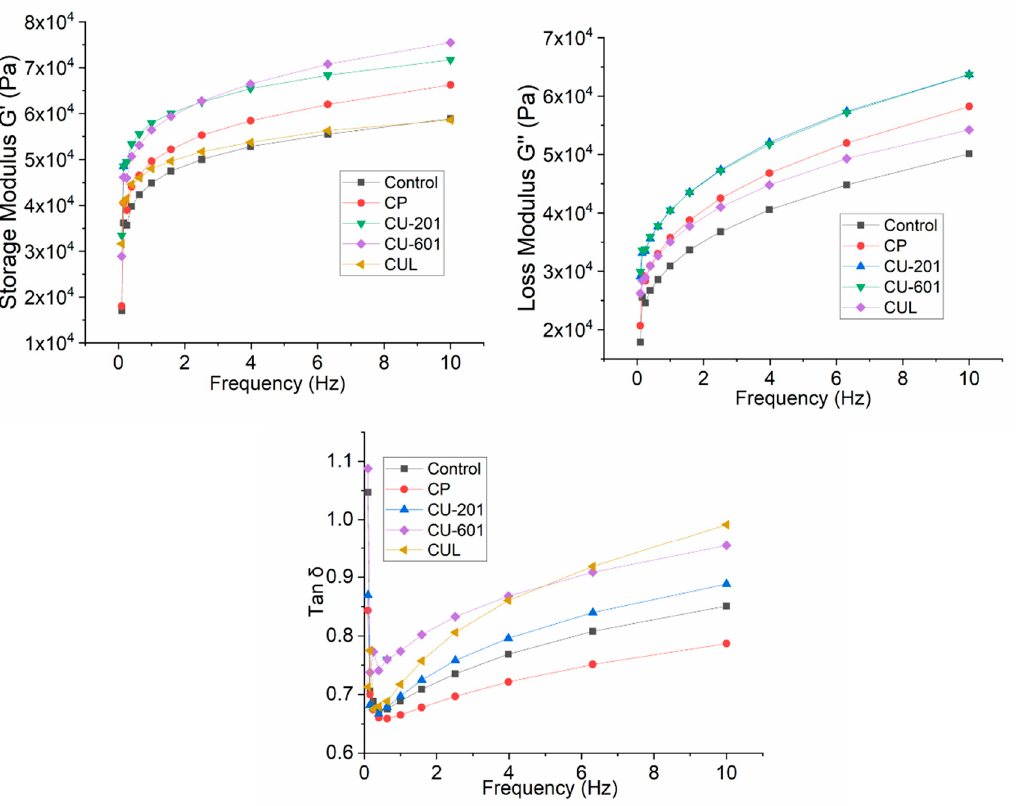
Figure 1. Rheological properties of cookies dough prepared with pectin having different molecular structure and molecular weight. CUL, CP, CU-601, and CU-201 indicate the names of pectin which were added in cookies. Reported graphs are the mean of triplicates for each treatment.